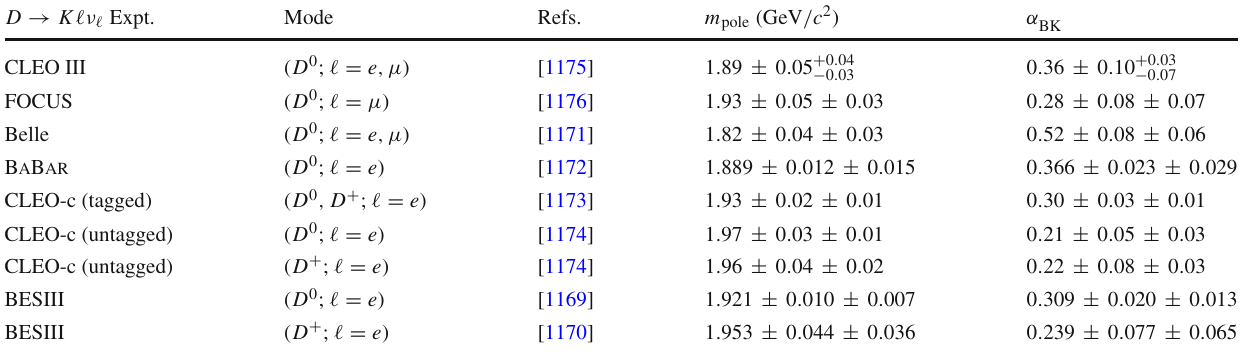
Table 271 Results for m pole and α BK from various experiments for D 0 → K − (cid:12) + ν and D + → ¯ K 0 (cid:12) + ν decays D → K (cid:12)ν (cid:12) Expt.